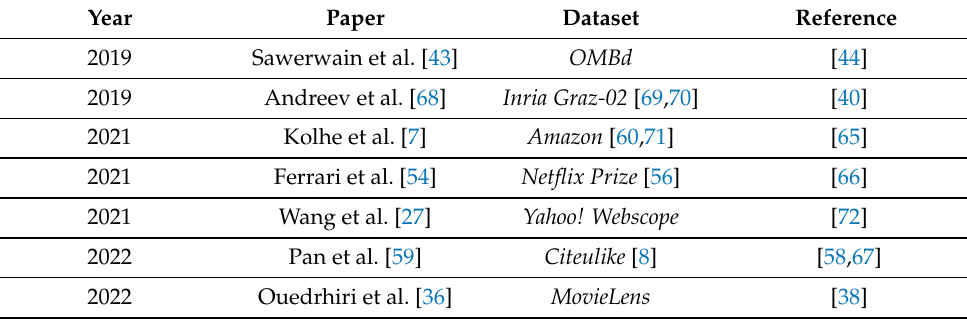
Table 1. Used dataset.